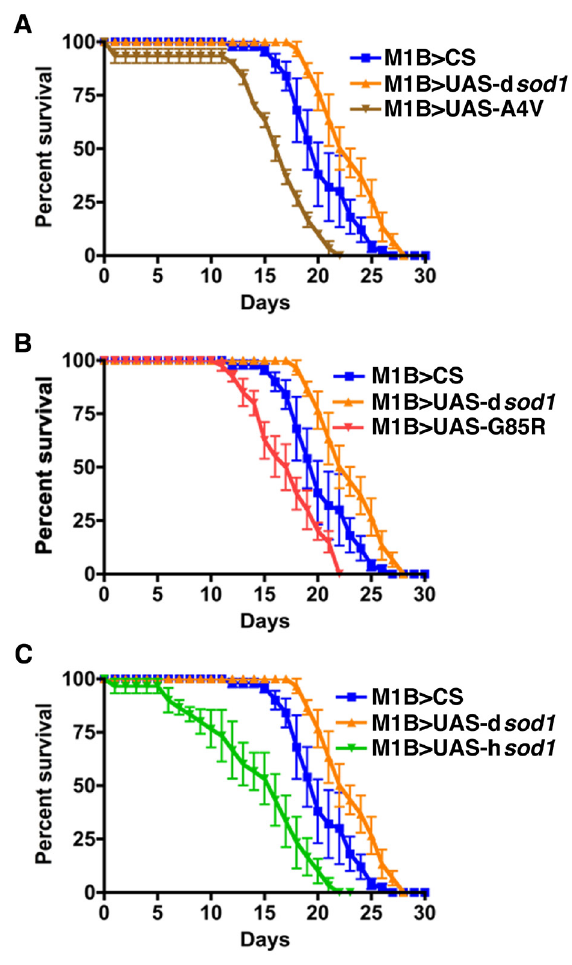
Figure 4. Human SOD1 overexpressed in glial cells accelerates fly death by BMAA. Shown are survival rates of 5 day-old male sod1 transgenic flies under 3 mM BMAA treatment (10 flies per vial). Panels A , B , and C represent flies expressing mutant human A4V, G85R, wild type SOD1 proteins, respectively, in comparison with control flies (M1B>CS and M1B>UAS-d sod1 ) in glia using the M1B-Gal4 driver. At the 50% survival rate, the longevity for A4V, G85R, and hSOD1 is reduced by 19%, 19%, 28%, respectively, compared to D42>UAS-d sod1 and D42>CS. Differences were considered statistically significant if p<0.05 and were calculated